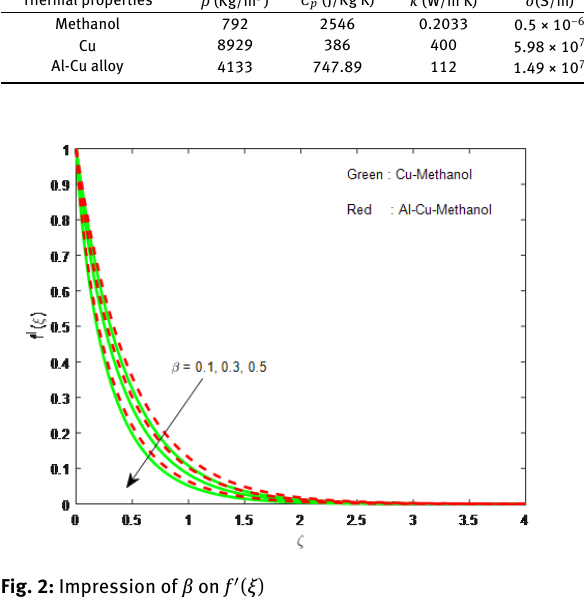
Fig. 2: Impression of β on f (cid:48) ( ξ )